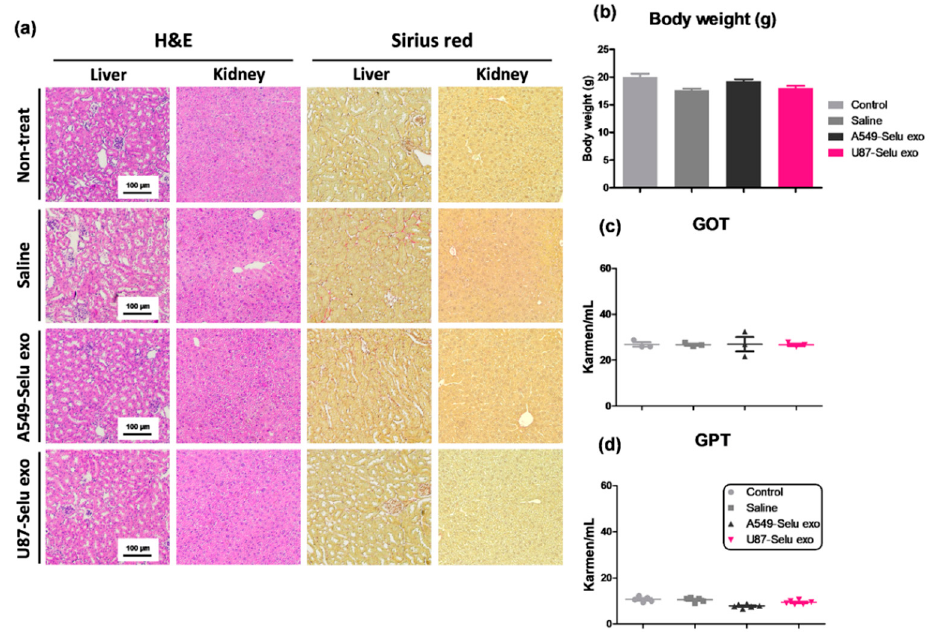
Figure 10. In vivo liver and kidney toxicity of U87-Selu exo and A549-Selu exo. ( a ) Bodyweight of U87MG-bearing mice treated with saline, A549-Selu exo, and U87-Selu exo. n = 5. Data represented as mean ± SD. Liver toxicity measurement. ( b ) GOT, ( c ) GPT, and ( d ) hematoxylin and eosin and Sirius red staining of liver and